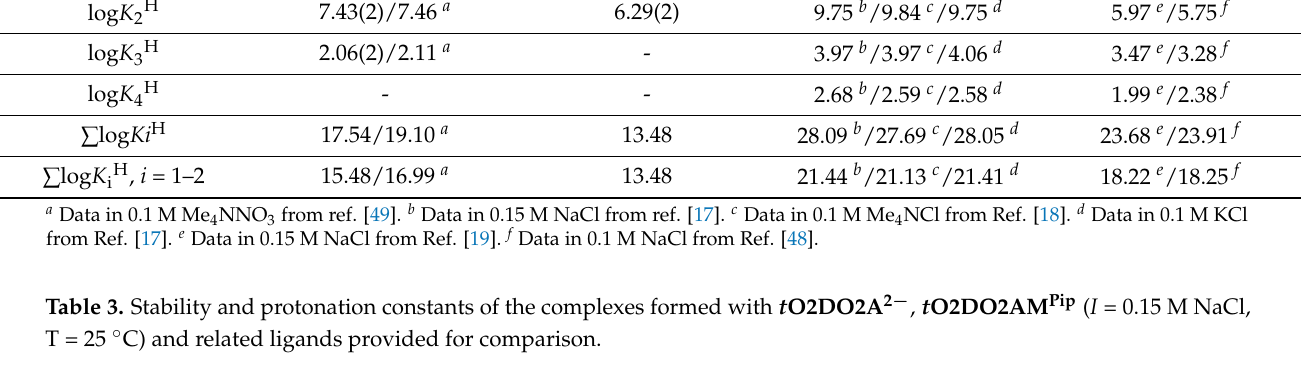
Table 3. Stability and protonation constants of the complexes formed with t O2DO2A 2 − , t O2DO2AM Pip ( I = 0.15 M NaCl, T = 25 ◦ C) and related ligands provided for comparison.